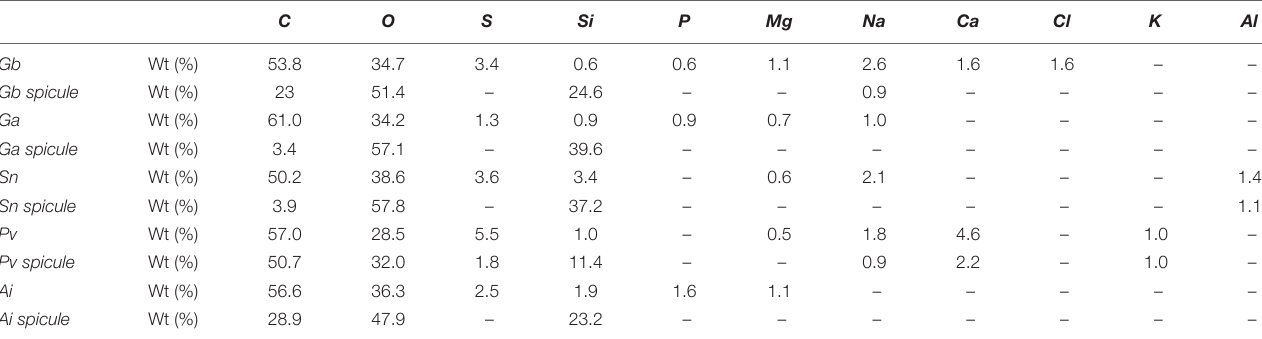
FIGURE 5 | SEM micrographs of the morphological elements and architecture of the flabellate sponge species, namely P. ventilabrum (A–F) and A. infundibuliformis (G–L) . (A) Cross-section showing megascleres (styles) piercing the sponge surface. (B) Detail of the surface with protruding spicules. (C–E) Various views of the organic matrix with embedded megascleres (styles and strongyles). (F) Aquiferous system with channel interconnected by different pores and inner organic matrix. (G,H) Sponge surface with organic matrix and skeletal elements (styles and oxeas). (J–K) Cellular elements (likely sperm cells) embedded in the inner organic matrix. TABLE 2 | Elemental composition weight (%) from the general morphological surface of marine sponge specimens (Gb, Ga, Sn, Pv, and Ai) and from their spicule structures obtained by EDS